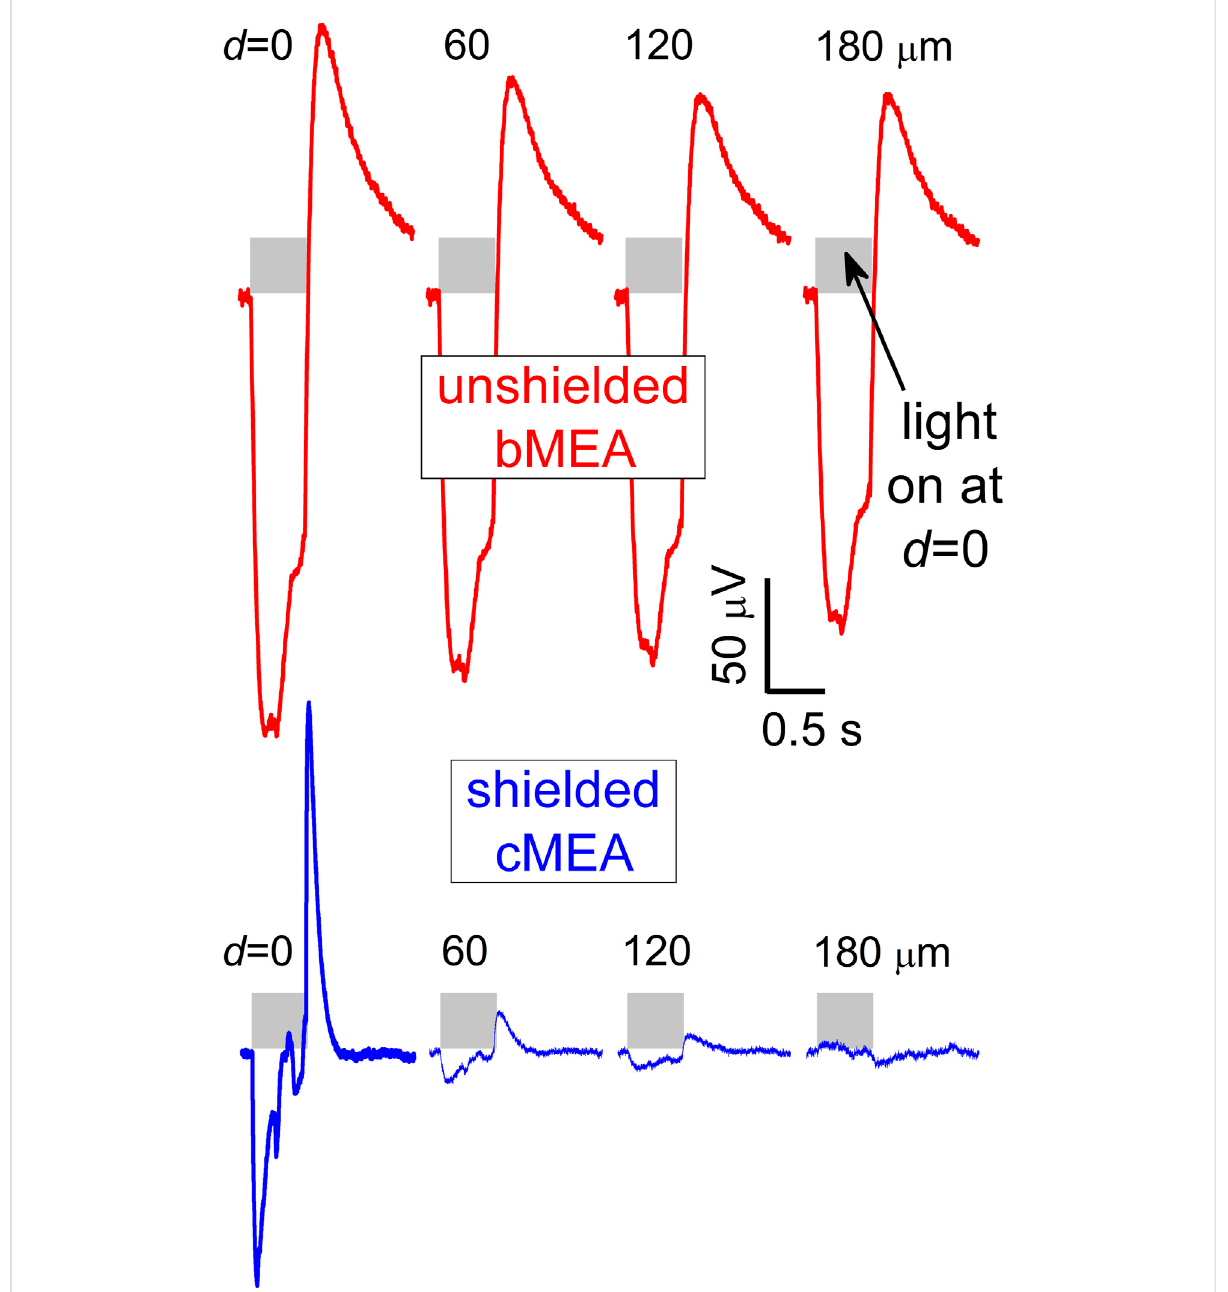
FIGURE 4 Recording with bMEA andcMEA underopticalexcitation. Voltage response vs.time ofoptogenetically-transfected HEK-293cells forthebMEA (upper) and cMEA (lower) devices in sensing regions at indicated distances d from backside-illuminated (0.5 s duration, shaded regions) stimulation location ( d = 0). Large extracellular potentials were evident at the site of stimulation and nearby electrodes in the bMEA but only at the site of stimulation on the cMEA. All windows correspond to 1.5 s